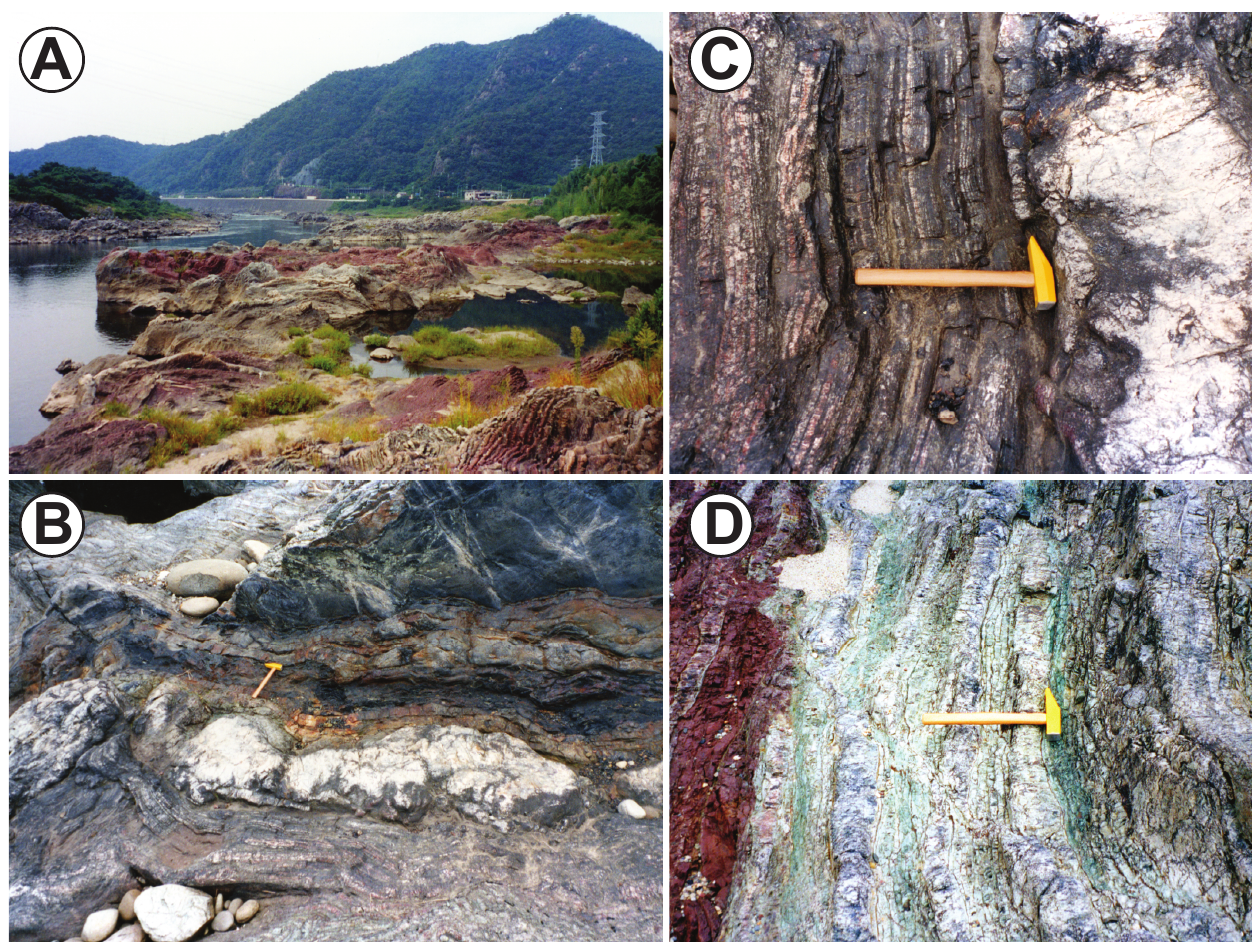
Fig. 3. (A) Katsuyama section on the Kiso River, Inuyama, Japan. (B) View of the Pliensbachian–Toarcian interval showing the organic matter-rich cherts beneath the continuous white bedded-chert horizon. (C) Close-up from photograph B of the T-OAE organic matter-rich cherts above the white bedded-chert horizon. (D) Upper interval of the Toarcian section showing the change between red-grey and green and red-green bedded cherts: the Toarcian Radiolarian Event occurs between the contact of the green to red-green bedded cherts. Note: hammer in photographs is approximately 30cm in length and the head of the hammer is in the direction of the base of the stratigraphic section (see Fig. 4 for stratigraphic